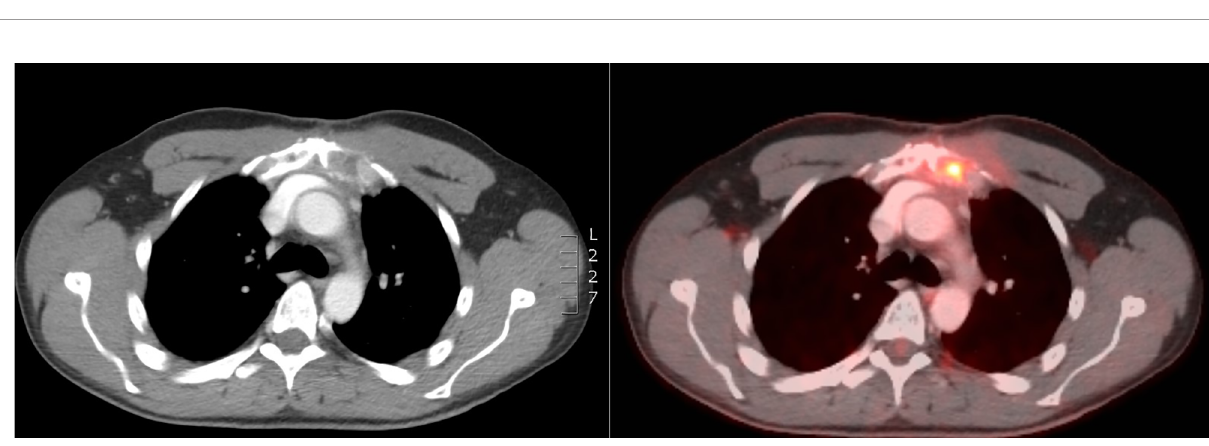
FIGURE 4 | CT scan 7 months after the end of RT showing volume decrease of the sternal